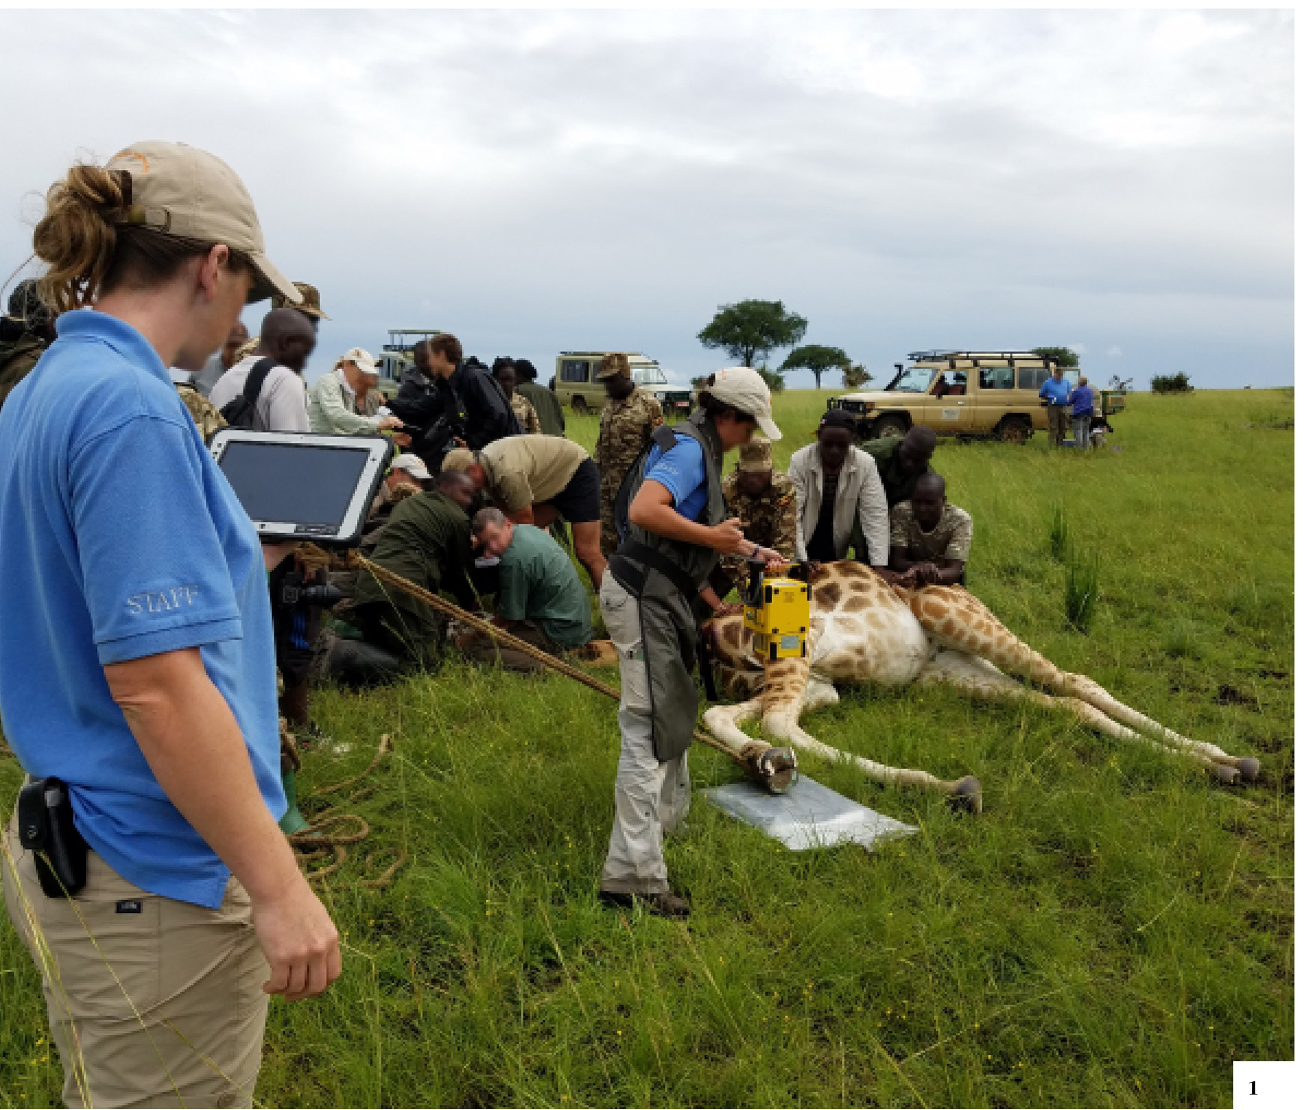
Fig 1. Giraffe positioning during immobilization. A leg rope was used on the giraffe for human safety during foot health evaluations and radiographs. The person holding the x-ray generator wore a leaded gown and a thyroid shield while collecting radiographic images. All other personnel were at a distance of at least two meters from the x-ray